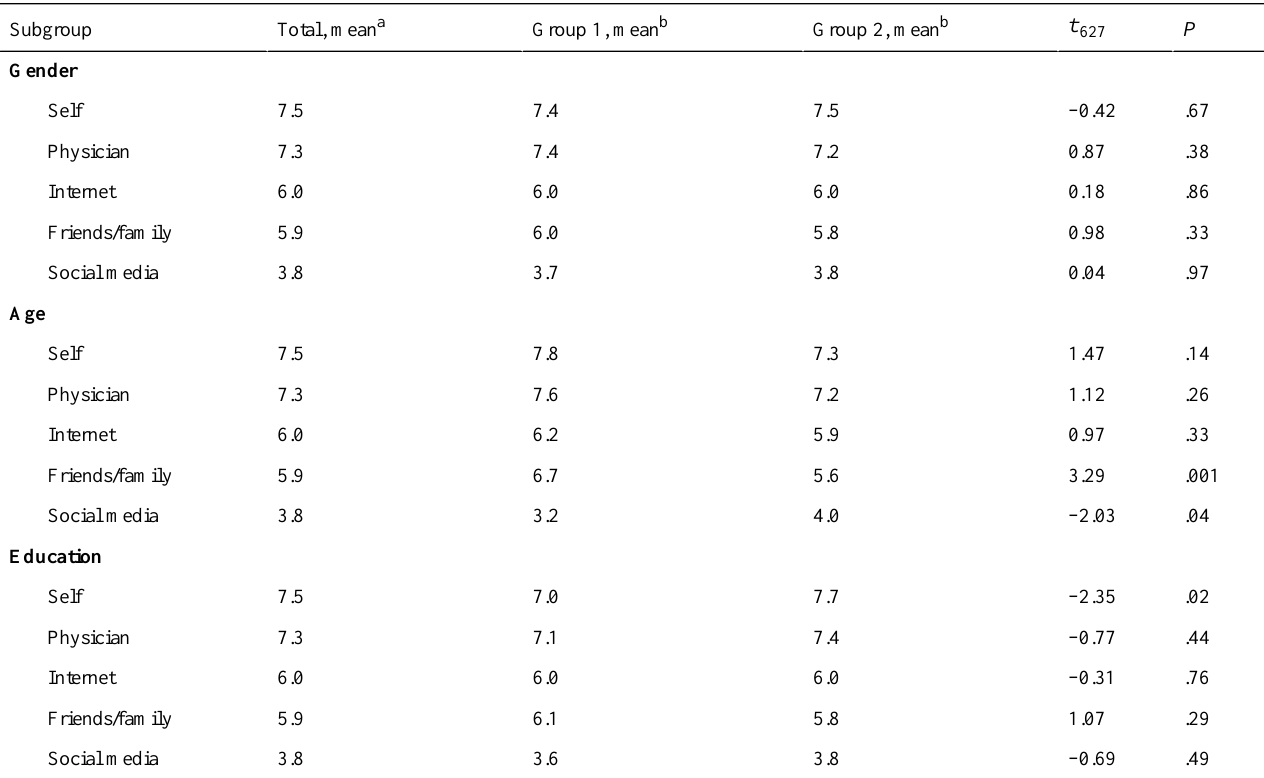
Table 5. Perceived reliability of sources for health-related